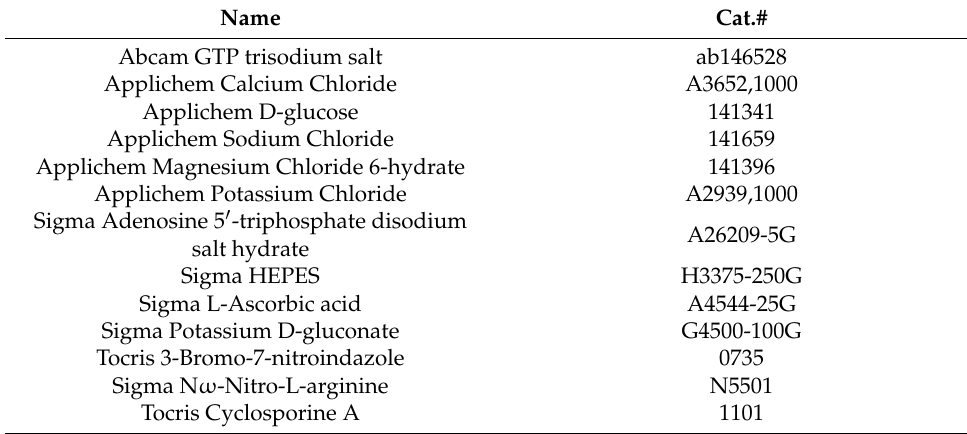
Table 1. Names of used chemicals with the catalogue